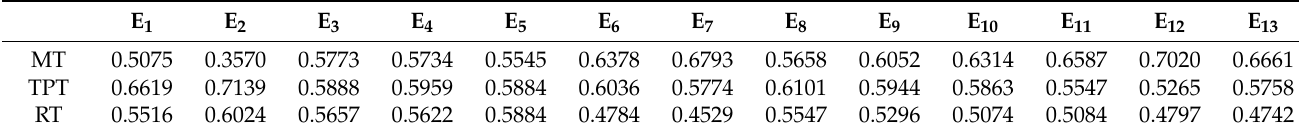
Table 7. Normalized decision matrix.